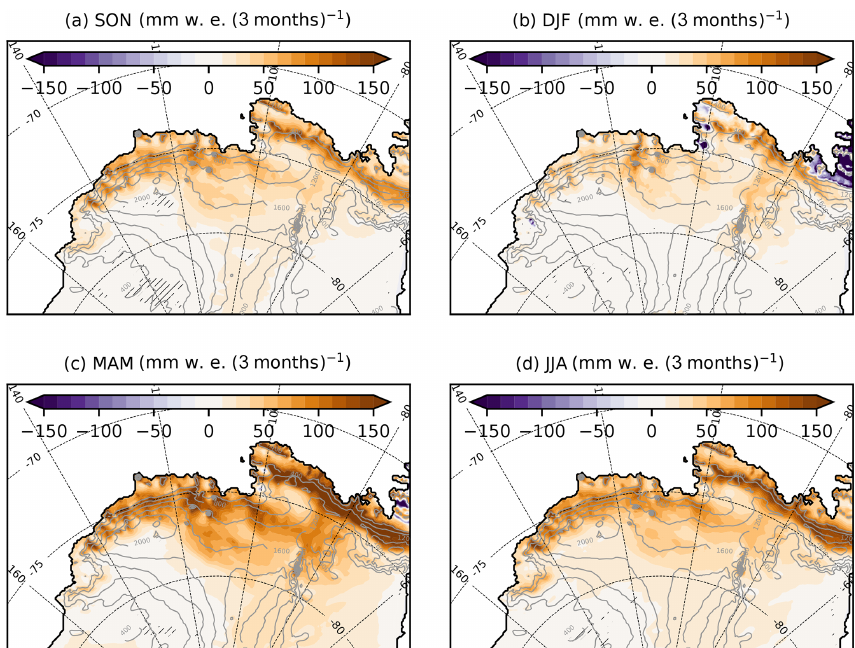
Figure 4. Changes in mean seasonal SMB (future minus present). Black narrow hatching indicates areas where the difference is not statisti- cally significant ( t test on 3-month means with a p value of 0.05). The ice-sheet topography is shown in grey (contours every 400m). Table 2. (a) Components of the surface liquid water budget and snowfall over individual ice shelves for the present day (regular) and future (bold). “Net liquid” is the sum of melting plus rainfall minus refreezing minus the liquid water retained in the firn without refreezing (zero in our case; not shown). Here we present average values in millimetre water equivalent per year (mmw . e . yr − 1 , i.e. kgm − 2 yr − 1 ), which is thought to be more meaningful than integrated values in terms of hydrofracture potential. (b) The melt-to-snowfall ratio. (c) The number of rain days (threshold of 1mmw . e . day − 1 ) and the number of melt days per year (threshold of 3mmw . e . day − 1 as in Donat-Magnin et al.,